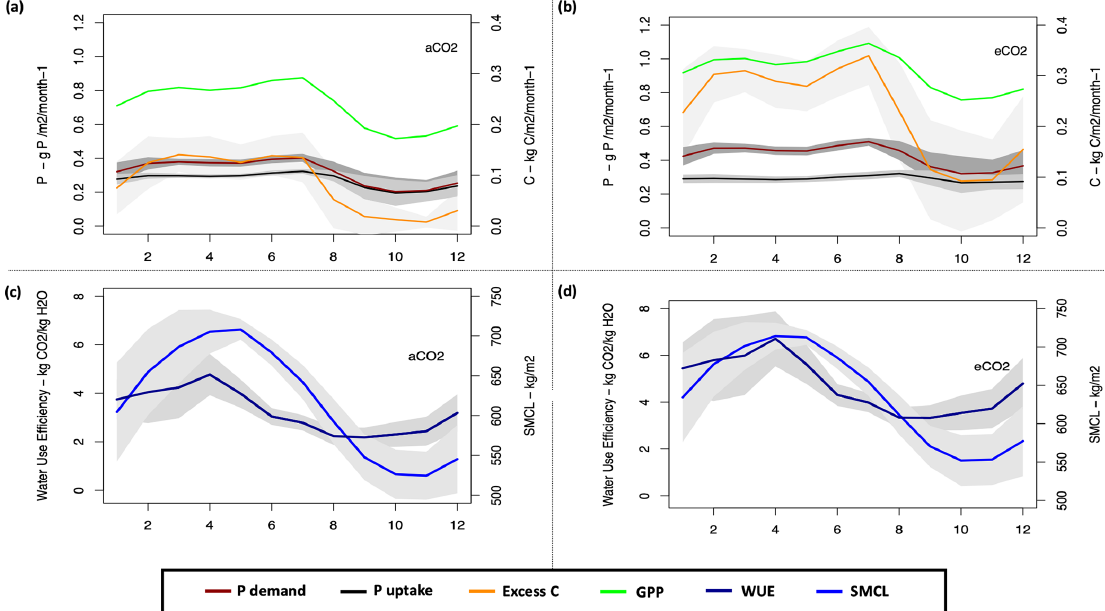
Figure 7. Simulated monthly plant P demand and uptake (gPm − 2 per month), excess C, and GPP (kgCm − 2 per month) under (a) aCO 2 and (b) eCO 2 conditions. Water use efficiency (gm − 2 per month) under (c) ambient CO 2 (aCO 2 ) and (d) eCO 2 conditions. The grey area represents the standard